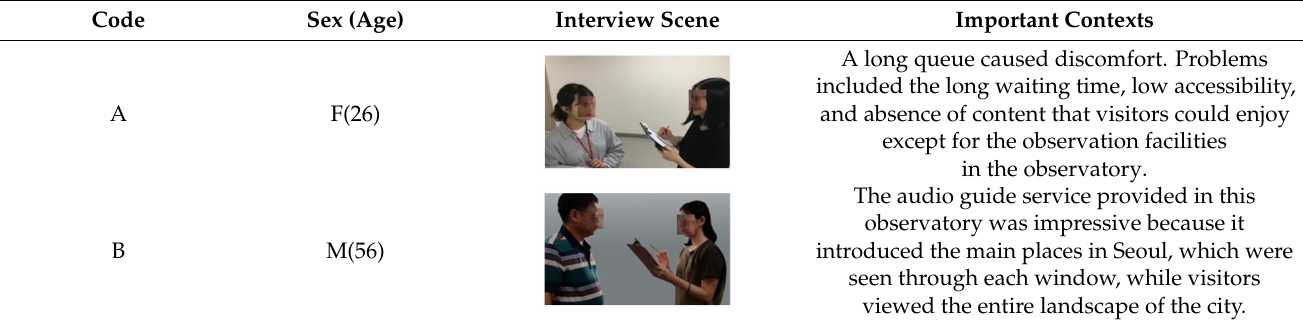
Table 1. Details of interviews with visitors to the Seoul Sky Observatory and their satisfaction with this observatory.